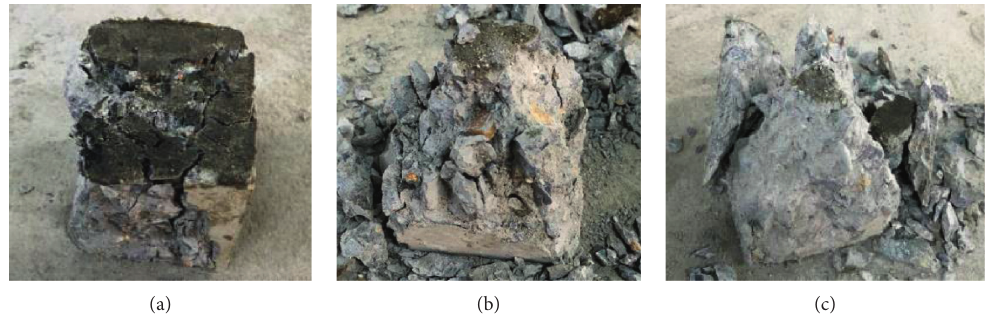
Figure 2: The failure mode under the effect of loading strain rate. (a) 1.0 × 10 –5 /s. (b) 1.0 × 10 –3 /s. (c) 1.0 × 10 –2 /s.